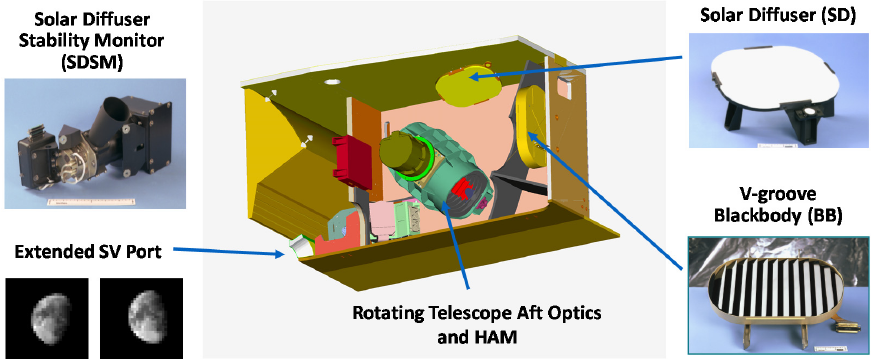
Figure 1. VIIRS sensor showing the positions of the SD, SDSM, BB and space view